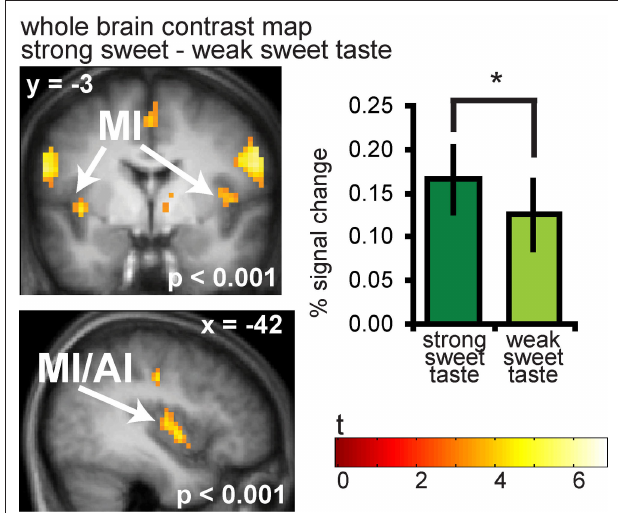
FIguRe 3 | Neural response in the insula to sweet taste. Coronal and sagittal sections of the insula showing response to strong sweet taste – weak sweet taste. In the bargraphs we plotted the average percent signal change for the two sweet taste conditions over subjects ( ± s.e.m.): ( Figure 6A and 6B ) strong sweet taste (dark green) and weak sweet taste (light green), averaged over subjects. The response was taken from the voxel that responded maximally, as identified in the SPM analysis. Thus, these estimates are non-independent, and are provided to illustrate the relative difference in neural